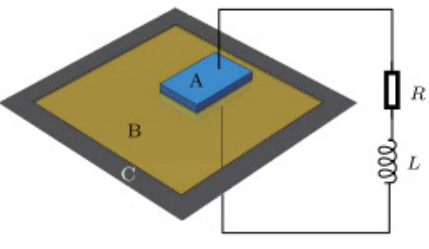
Figure 11. The structural sketch [47].